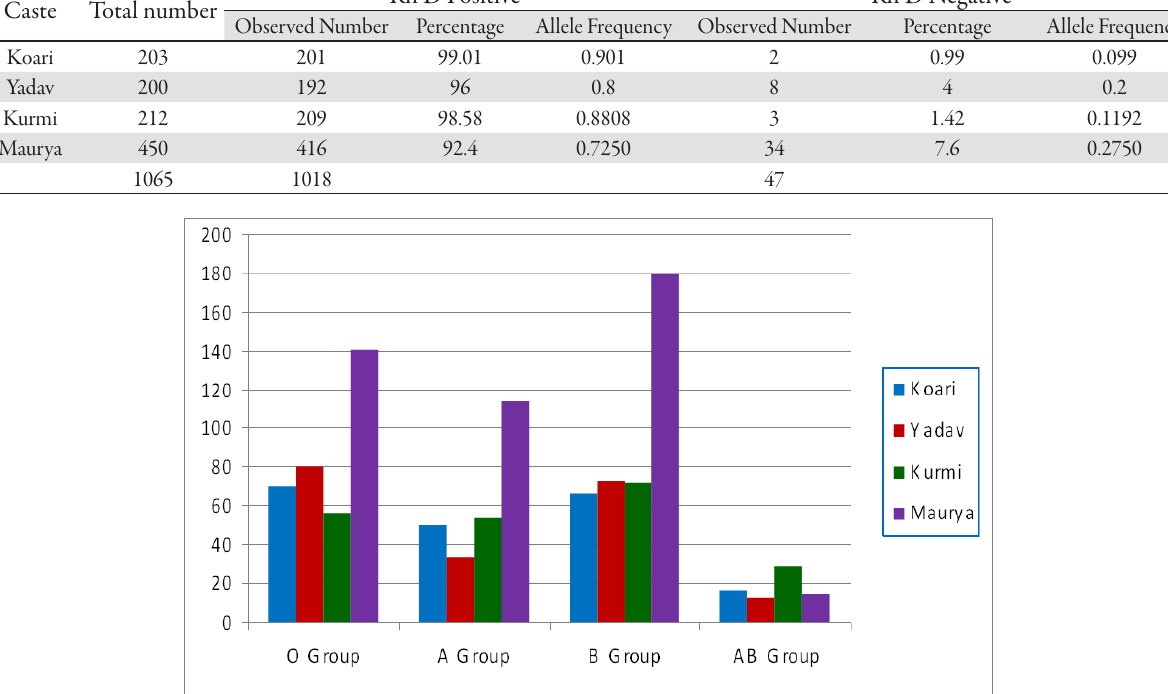
Fig. 3. Gender-wise categorization of different ABO blood groups phenotypes